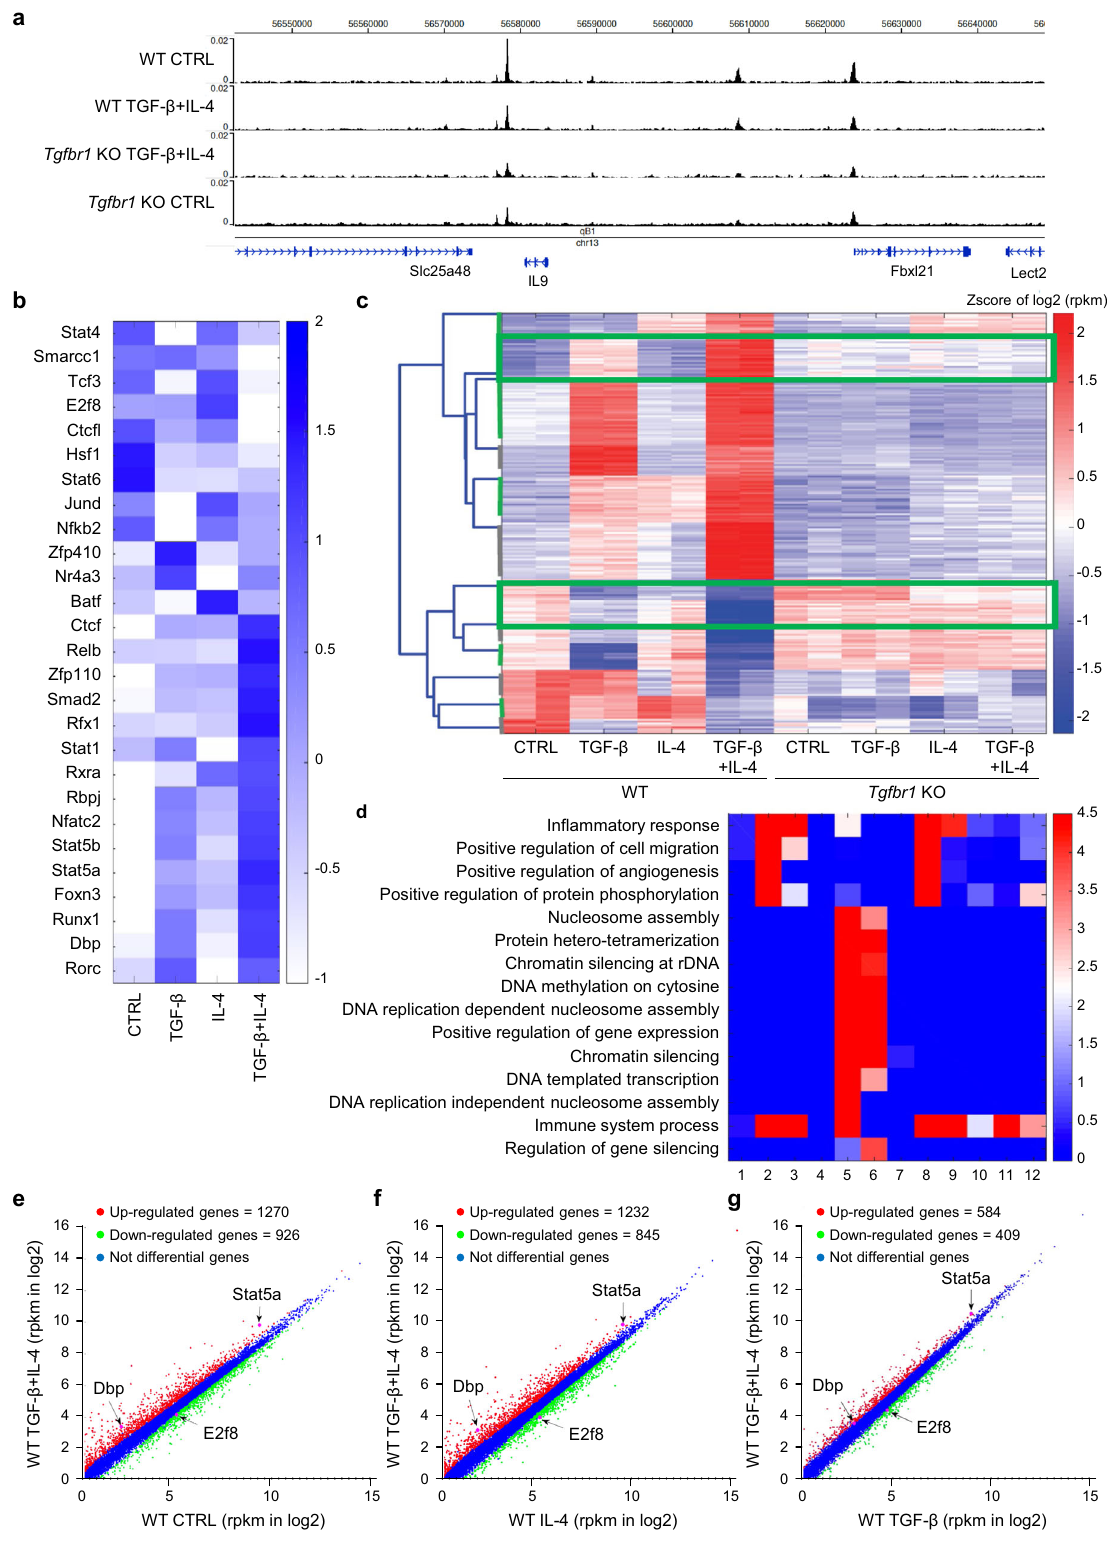
RorcDbpRunx1Foxn3Stat5aStat5bNfatc2RbpjRxraRfx1